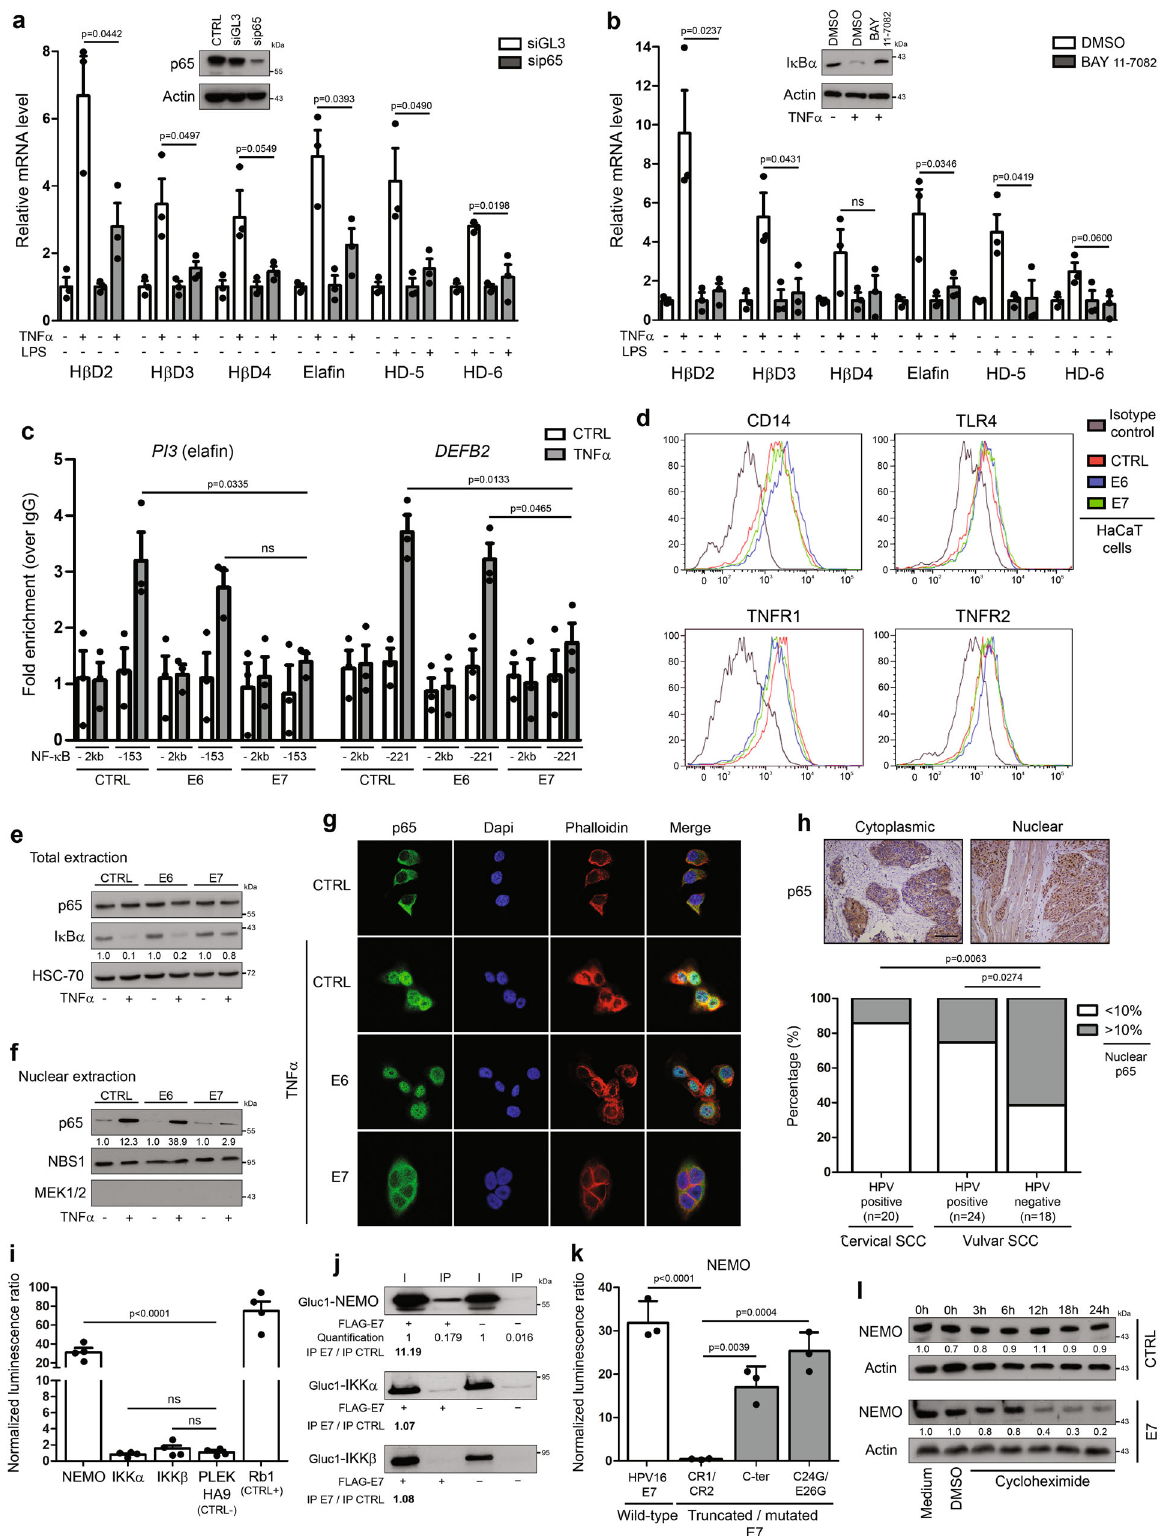
immunoreactivity was clearly observed in HPV18-positive organo- typic raft cultures, E7-transduced keratinocytes as well as in HPV- positive (pre)neoplastic lesions compared to respective controls (Fig. 4e, f, i). Exclusively detected at the cell membrane in uninfected cells/tissues, an intense cytoplasmic/nuclear β -catenin immunor- eactivity was reported in case of HPV infection/E7